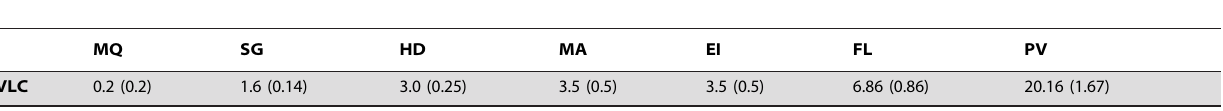
Table 2. r distances ( 6 s.d.) between the mtDNA pools of Victoria Land Coast (VLC) samples and those of potential source populations, representing all major extant southern elephant seal breeding colonies.